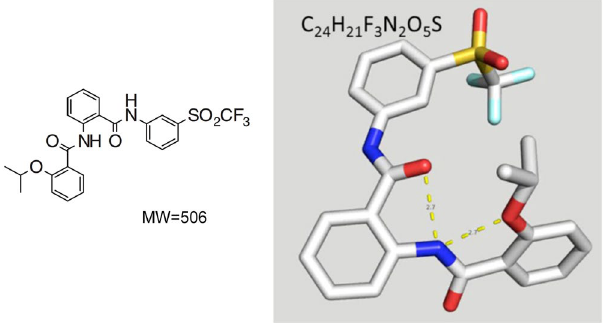
Figure 7. Chemical structure of ML290 13 . 2-Isopropoxy-N-(2-(3-(tri fluoromethyl sulfonyl) phenyl carbamoyl) phenyl)